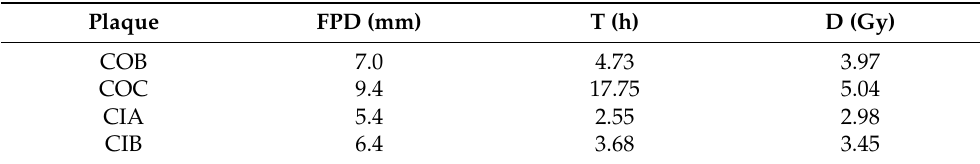
Figure 3. Zenithal ( left ) and lateral ( right ) pictures of the experimental setup designed to measure 2D dose distributions in water for Ru ophthalmic applicators. A COB plaque is set up in this figure. Two-dimensional dose distributions perpendicular to the plaque axis were measured for each plaque type using the experimental setup described. Details on the film-to-plaque distance, irradiation time, and estimated dose to the center of the film for each plaque type are provided in Table 2. The irradiated film pieces were scanned 24 h after irradiation on a 10000XL EPSON flatbed scanner in transmission mode, 16 bits per color channel and 150 dpi resolution. Each film cut was scanned at the center of the scanner together with an unexposed control film cut. Table 2. Film–plaque distance (FPD), irradiation time (T), and estimated dose (D) to the center of the film piece for each plaque